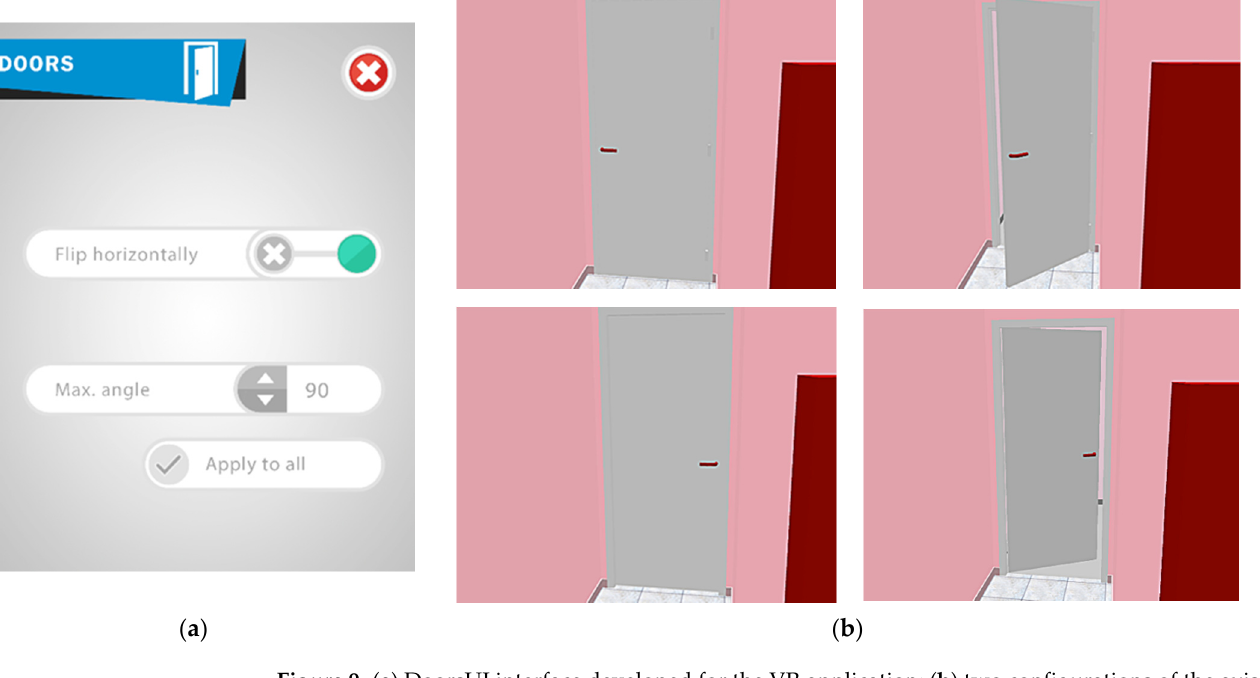
Figure 9. ( a ) DoorsUI interface developed for the VR application; ( b ) two configurations of the axis rotation of a door: Above is the initial location of door hinges when it is closed and open, respectively; below is the result after checking the ‘Flip horizontally’ option.